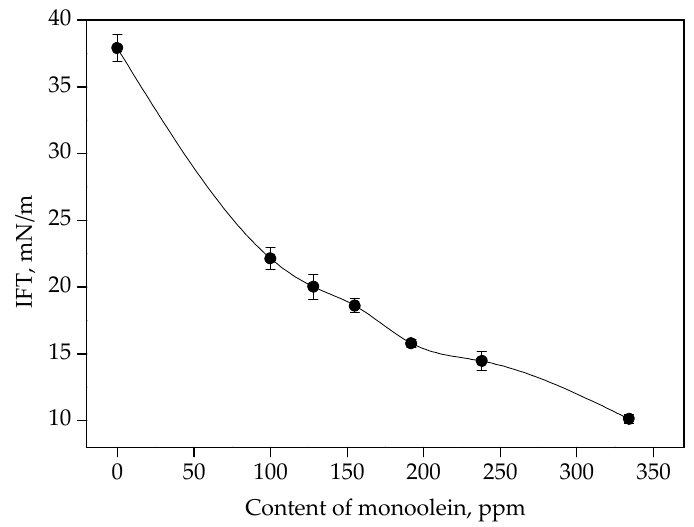
Figure 7. IFT under different contents of monoolein.